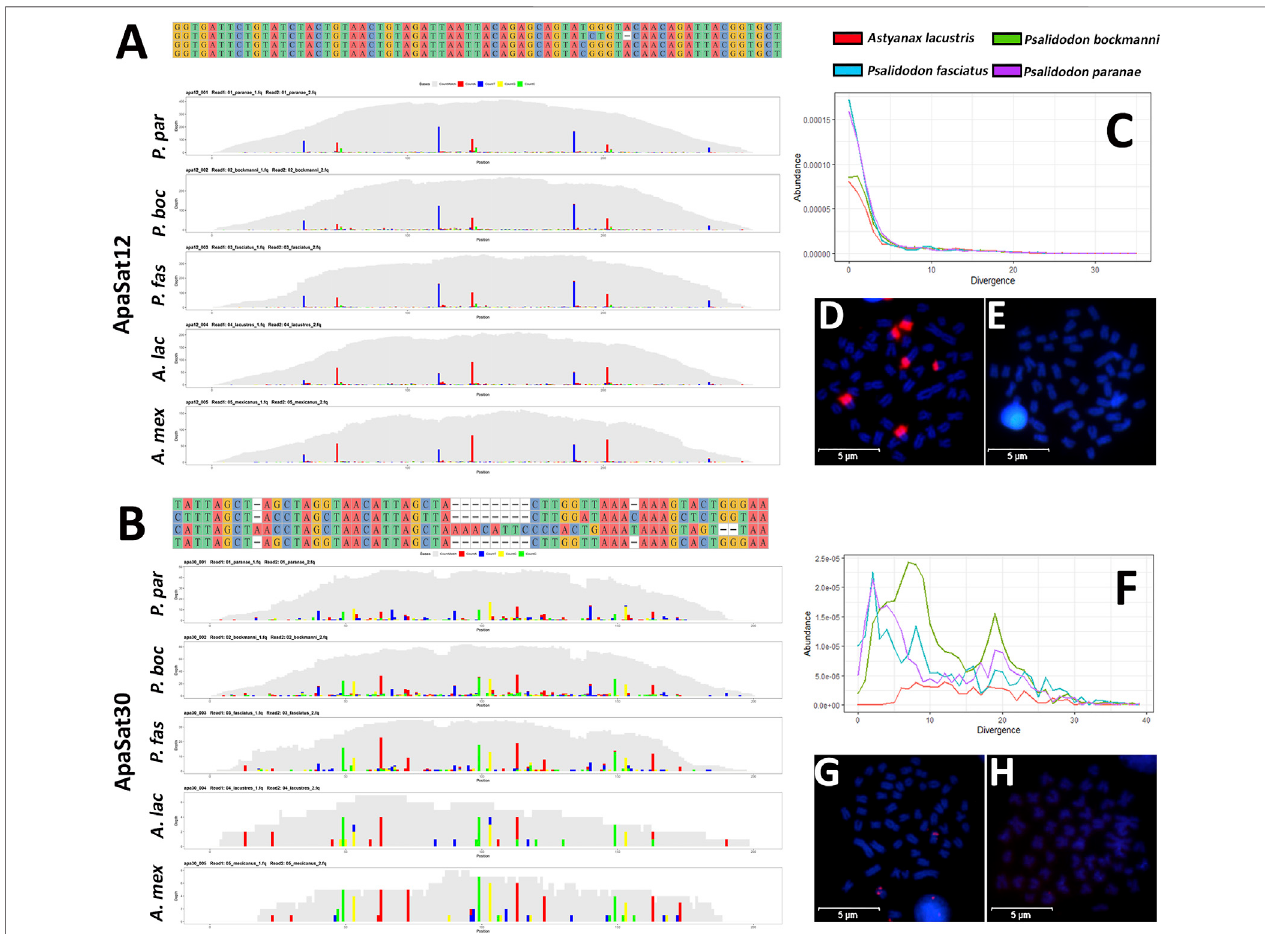
FIGURE1| RepeatslandscapesofconservedsatDNAfamiliesconserved betweenPsalidodonandAstyanax.Alignmentsandrepeatpro fi lersofApaSat12-69 (A) and Apasat30-50 (B) . Repeat landscapes ofApasat12-69 (C) ,Apasat30-50 (F) demonstrate theabundance and divergence ofthese satDNAs intheanalyzedspecies. In addition, these satDNAs demonstrated FISH signals in all Psalidodon species (D and G) , but not in Astyanax (E and H) .